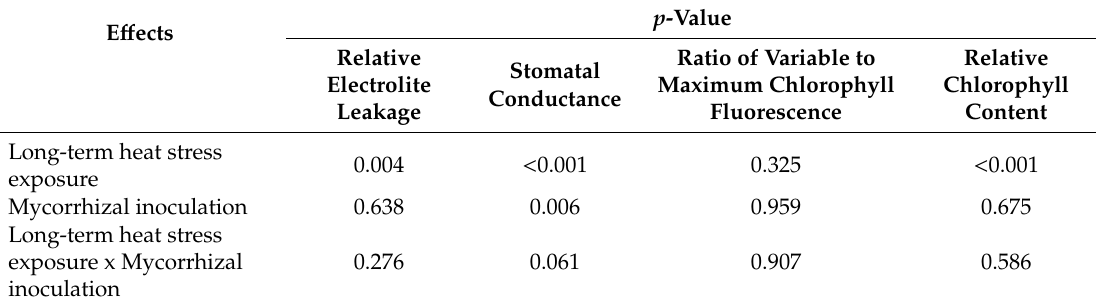
Table 2. P -values of the test for the analysis of the e ff ects of the di ff erent factors and their interactions. Statistical analysis was done by fitting a linear model considering two fixed factors (mycorrhizal inoculation and long-term heat stress exposure), their interaction, and an error covariance matrix allowing correlation among observations from the same plant exposed to the di ff erent treatments. Significant e ff ect, p -value <